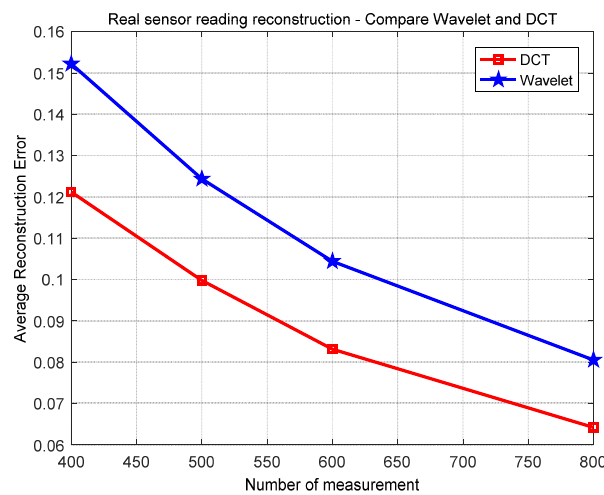
Figure 9. Reconstruction errors from the CS reconstruction processes with DCT and Wavelet as sparsifying basics Each image or picture is not considered to be sampled.